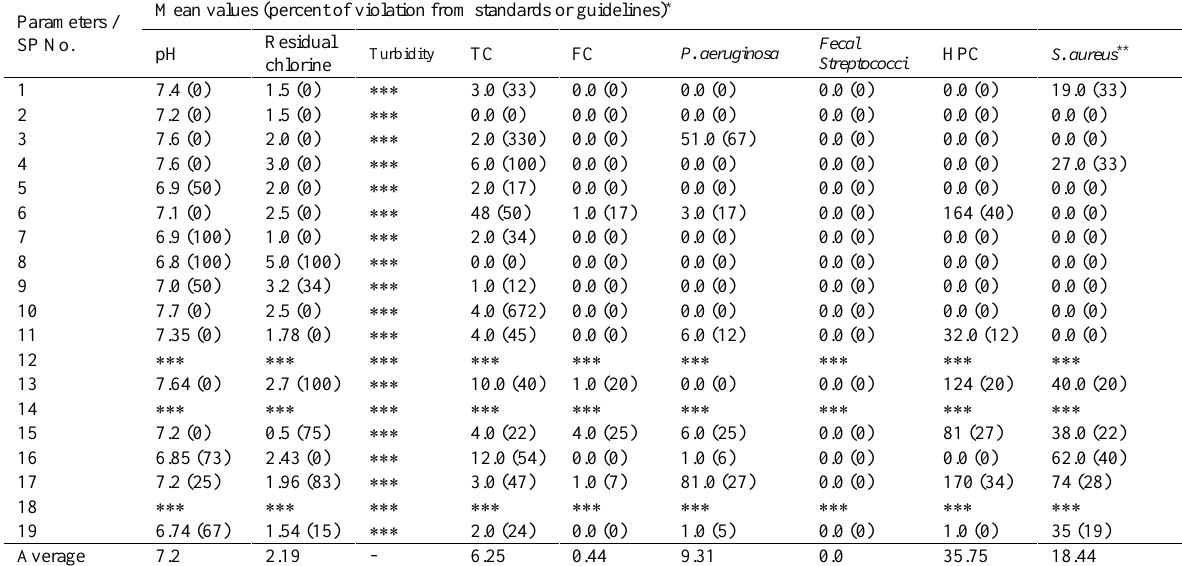
Table 4. Mean value of the assessed parameters in each swimming pool during 2014 Parameters / SP